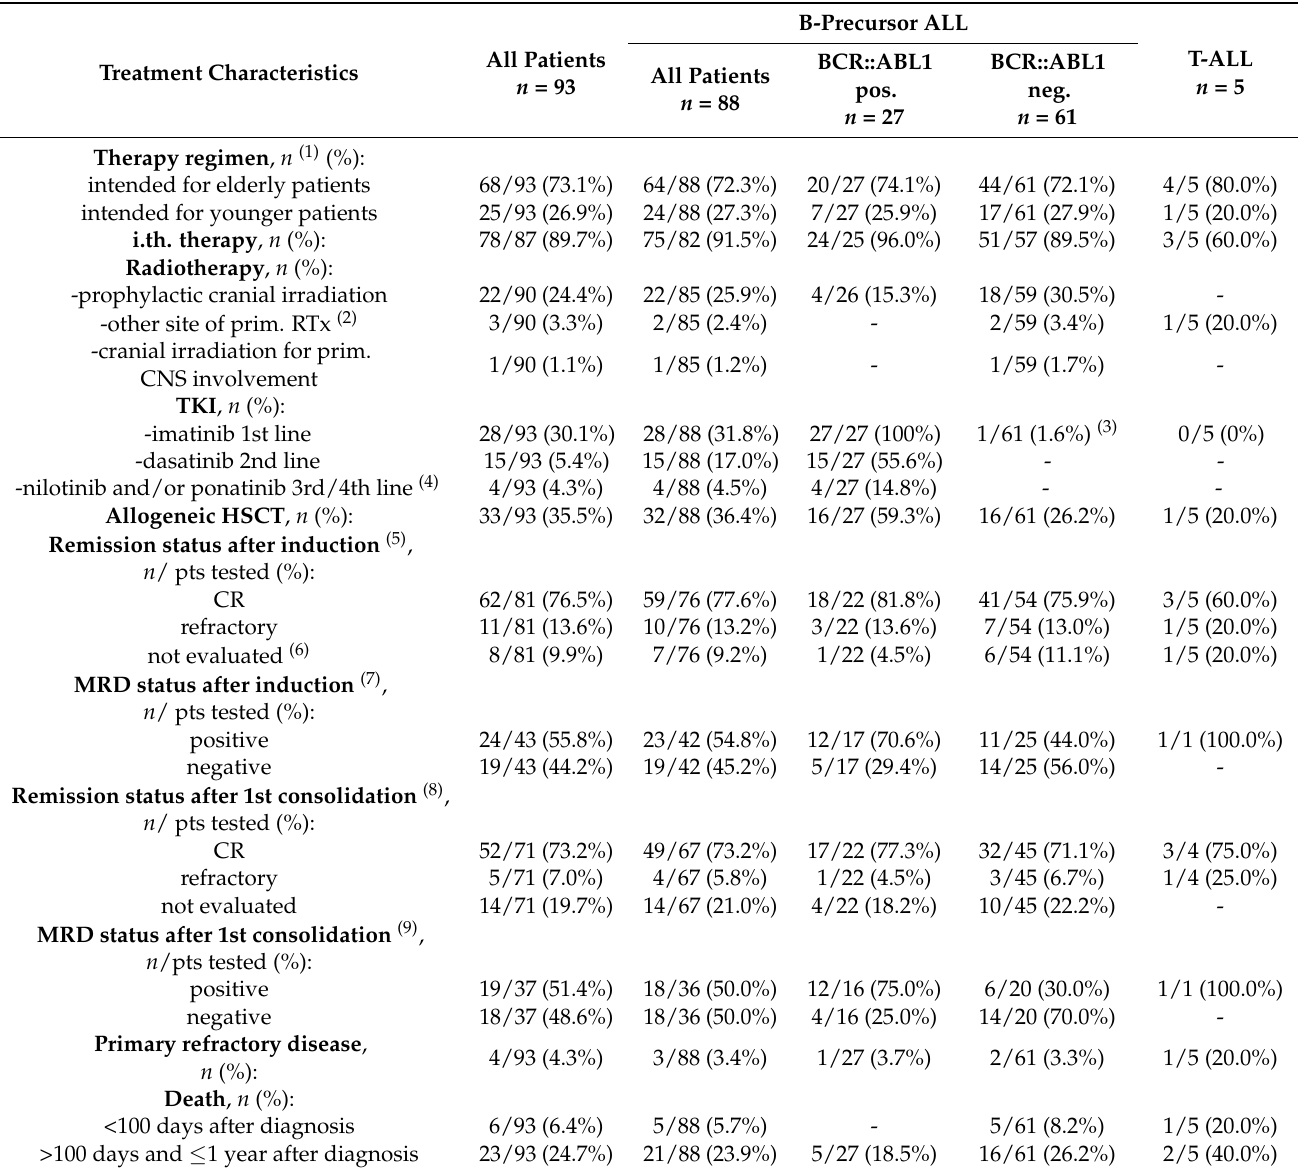
Table 2. Treatment characteristics of all elderly ALL patients (>55 years at diagnosis) with B-precursor and T-ALL receiving intensive chemotherapy (93